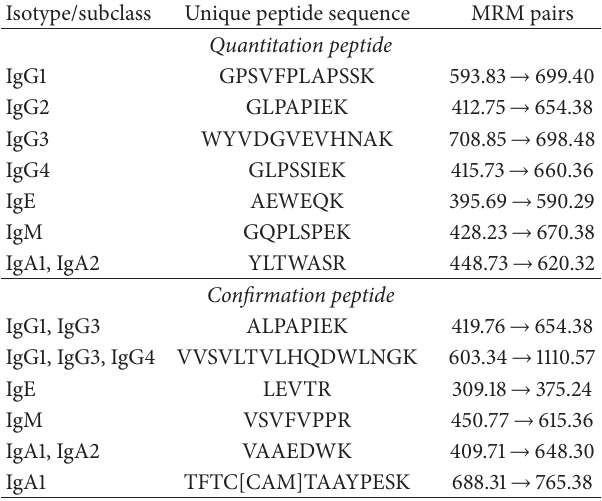
Table 1: List of unique peptides and MRMs for ADA iso- topes/subclasses used in the immunocapture-LC/MS